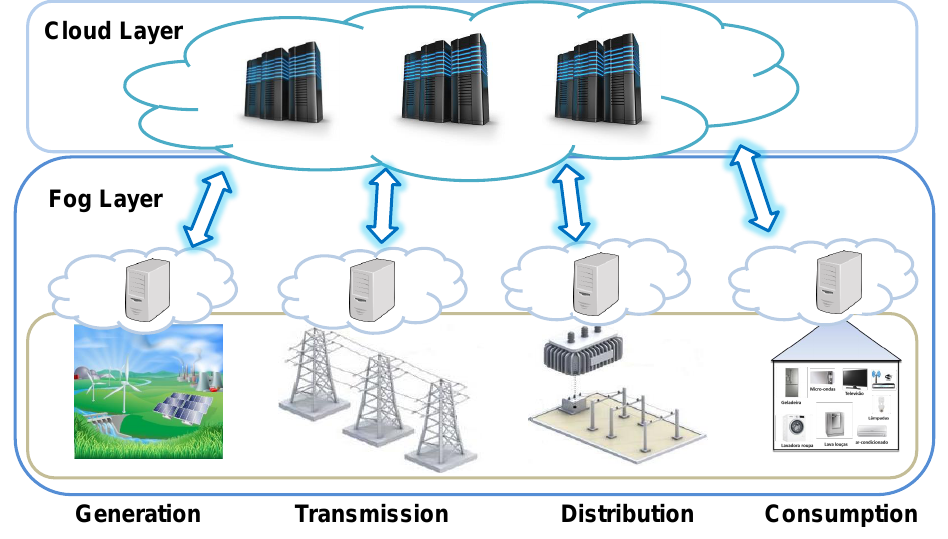
Figure 1. Smart grid topology aided by the Fog and